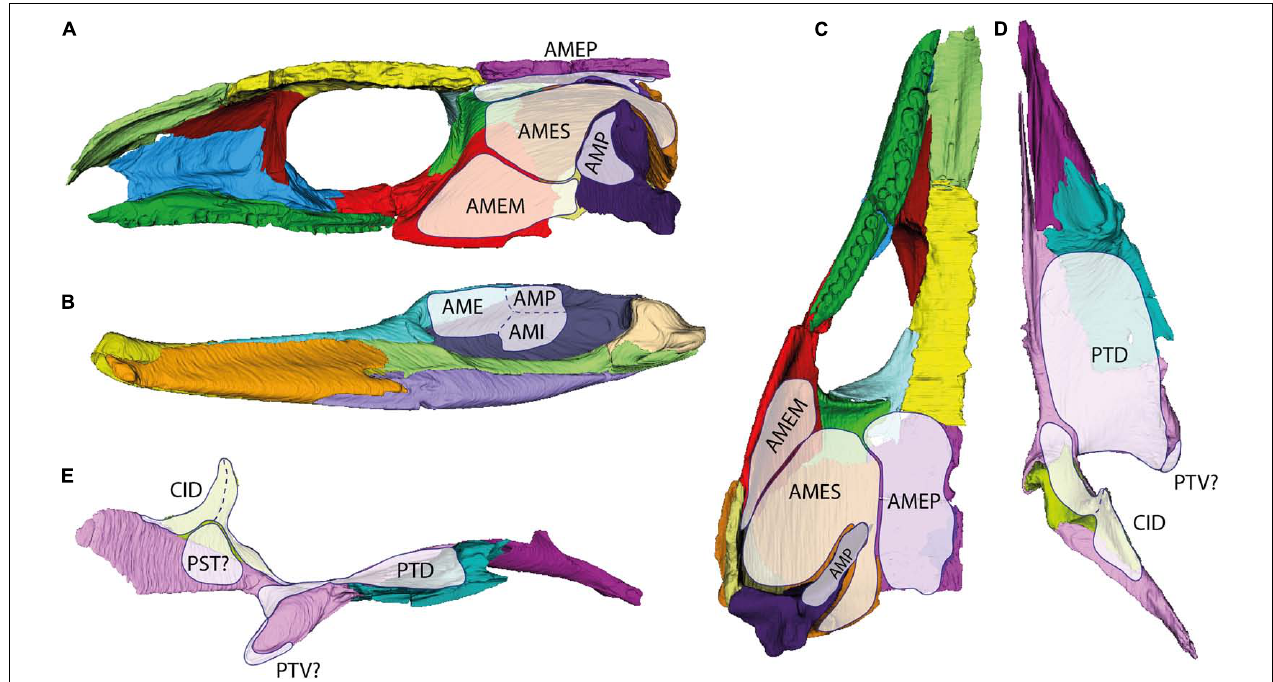
FIGURE 12 | Rough position of the jaw adductor musculature in the temporal dermatocranium of OMNH 44816 in medial (A) and ventral view (C) ; as well as of the internal adductor and constrictor musculature in the palate and epipterygoid in dorsal (D) and lateral view (E) , and the insertion of all named muscles onto the mandible in medial view (B) . AME, adductor mandibulae externus; AMEM, adductor mandibulae externus medialis; AMEP, adductor mandibulae externus profundus; AMES, adductor mandibulae externus superficialis; AMI, adductor mandibulae internus; AMP, adductor mandibulae posterior; CID, constrictor internus dorsalis; PST, pseudotemporalis; PTD, pterygoideus dorsalis; PTV, pterygoideus